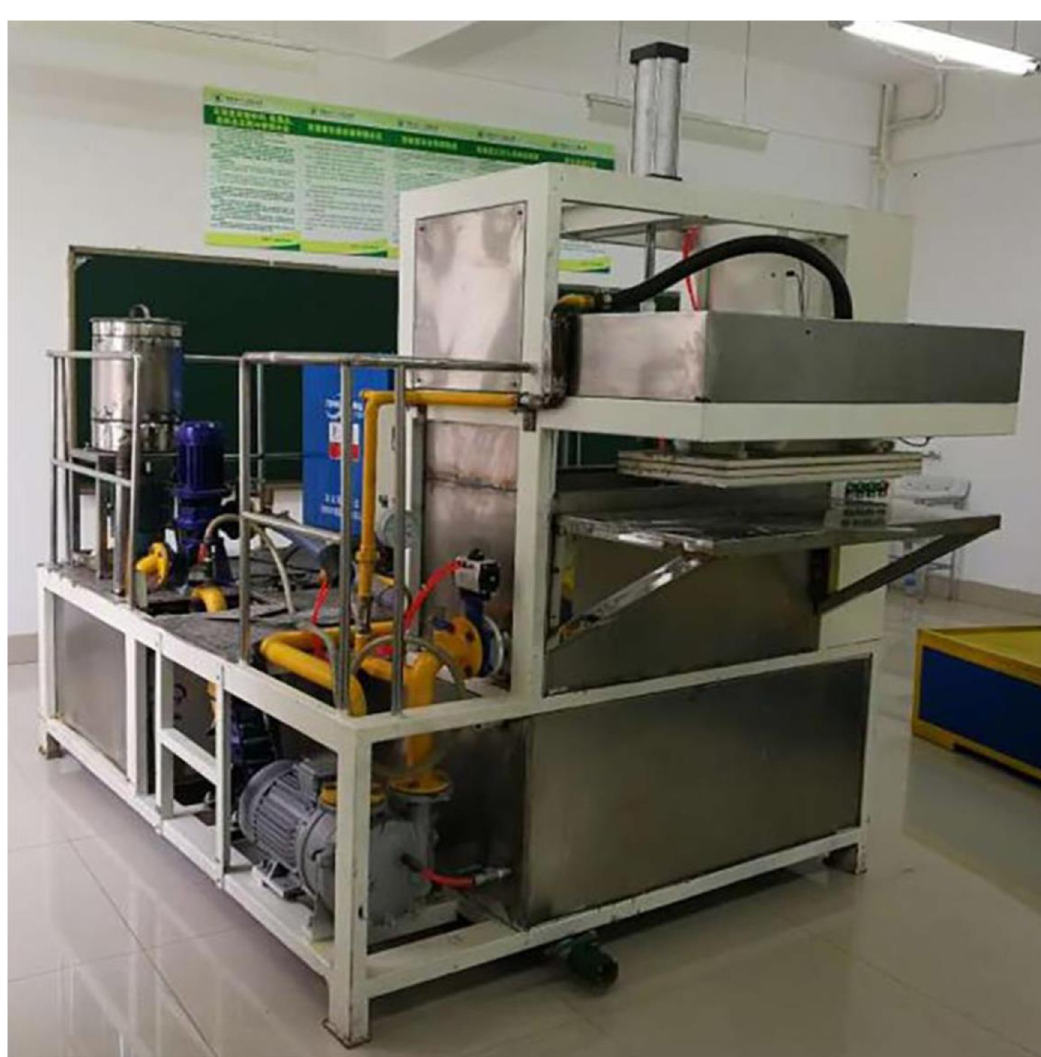
Fig 2. Physical diagram of pneumatic molding machine.